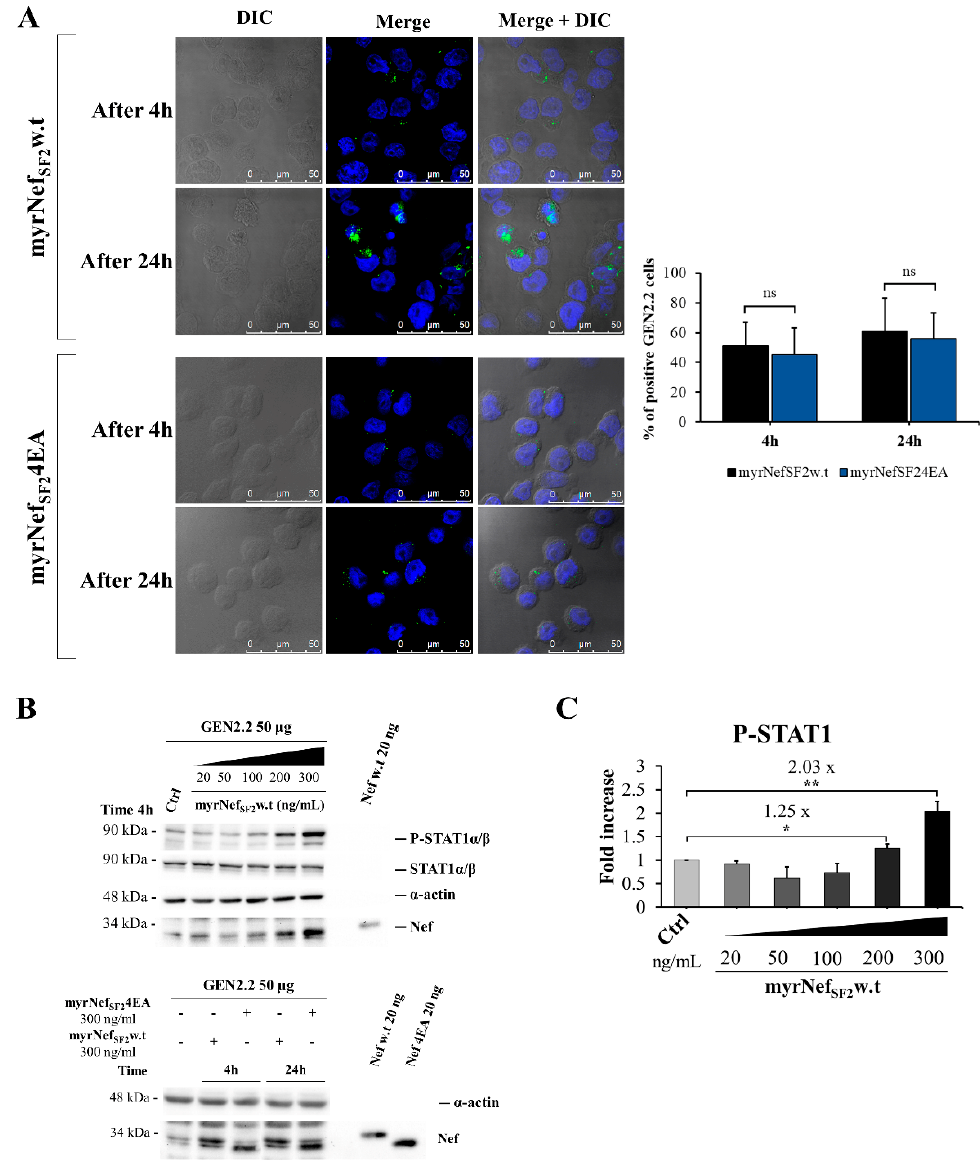
Figure 4. Internalization of Nef protein by GEN2.2 cells. ( A ) Confocal microscopy analysis of GEN2.2 cells seeded at 0.1 × 10 6 cells/150 µL and treated for 4 h and 24 h with 300 ng/mL of myrNef SF2 w.t and myrNef SF2 4EA conjugated with AlexaFluor488 (green). Afterwards, cells were placed on a microscope slide and fixed in PFA 4%. Samples were mounted with Vectashield antifade